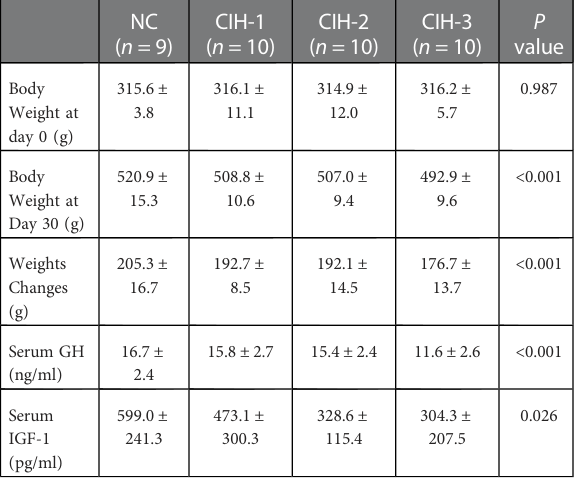
TABLE 1 The body weight, body weight changes, and serum GH/IGF-1 concentrations among the four group of rats after 30